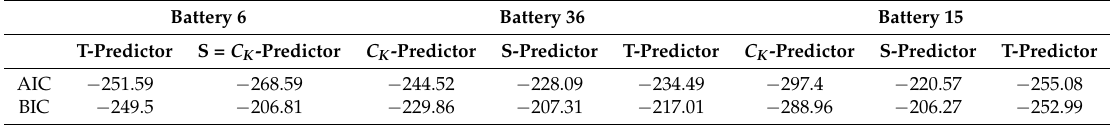
Figure 10. Auto-correlation and partial correlation of the selected battery data. Table 4. Fitted models AIC and BICvalues.